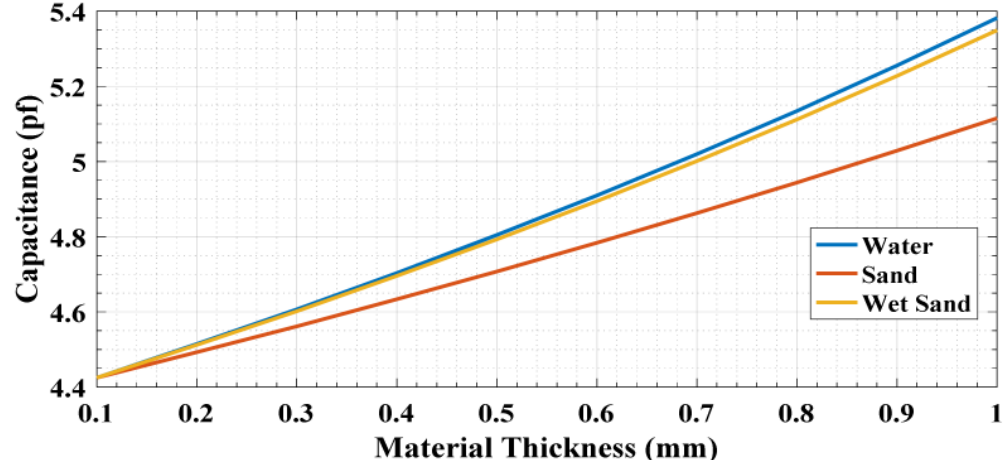
Figure 25. Variation of capacitance with respect to material